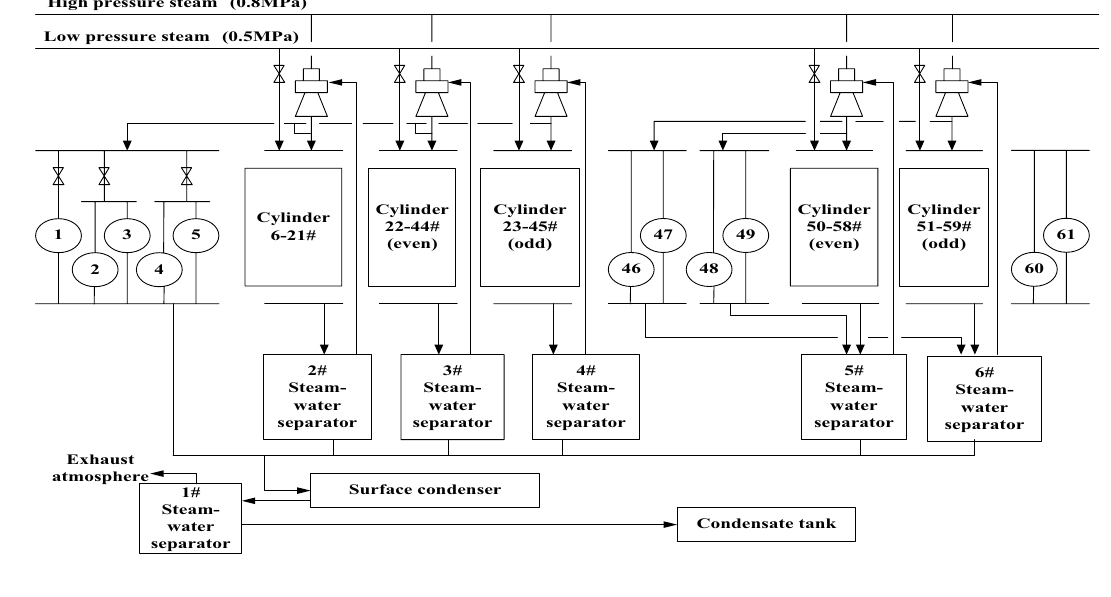
Fig. 1 Schematic diagram of the studied condensate and steam